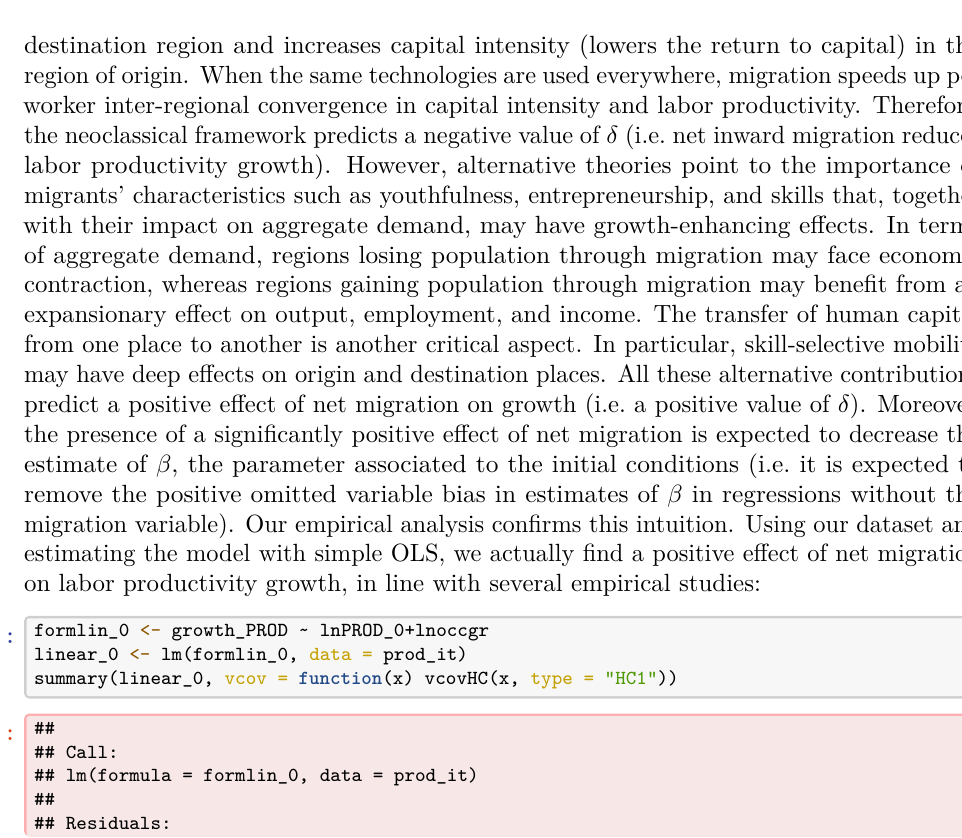
Internal net migration